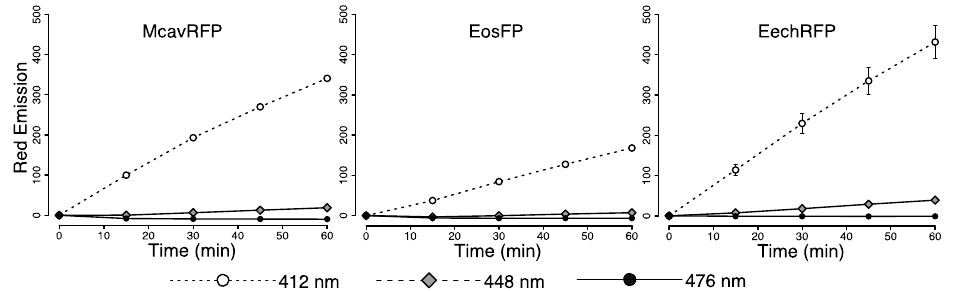
Figure 3. In vitro photoconversion of purified pcRFPs under 412, 448 and 476 nm light. Photoconversion measured as red (580–581 nm) fluorescence emission (ex = 530) every 15 min for 60 min under 60 μ mol photons·m − 2 ·s − 1 . Mean ± S.D., n = 3. photons · m − 2 · s − 1 . Mean ± S.D., n = 3.